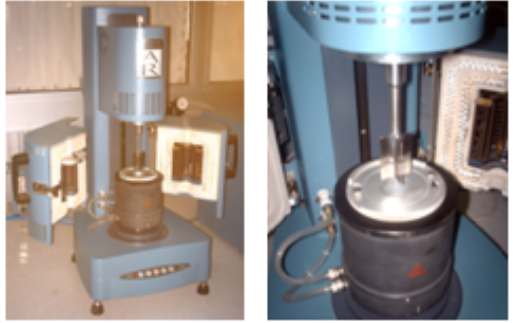
Figure 8: Rheometer AR 2000 with a geometry vane.